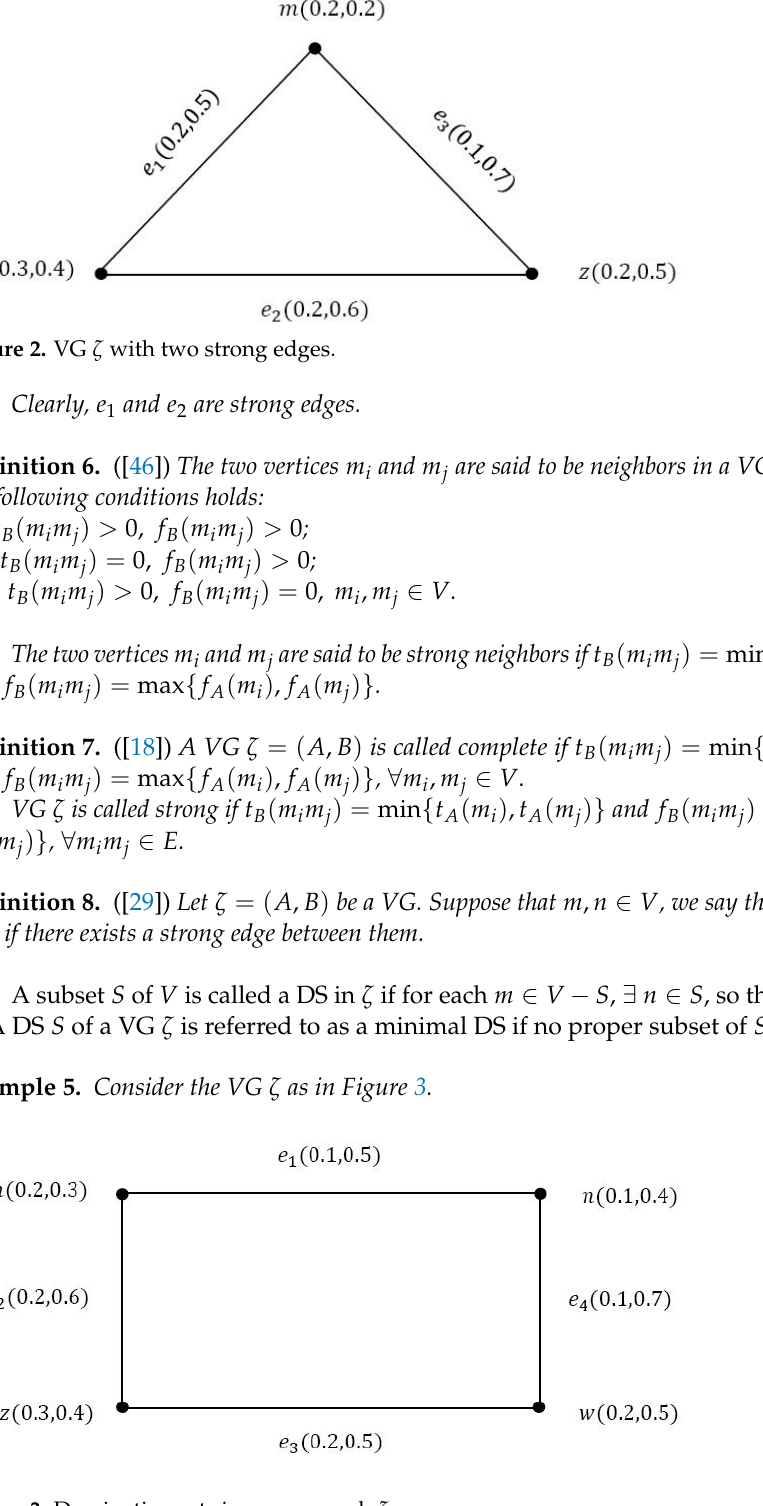
Figure 3. Dominating sets in vague graph ζ